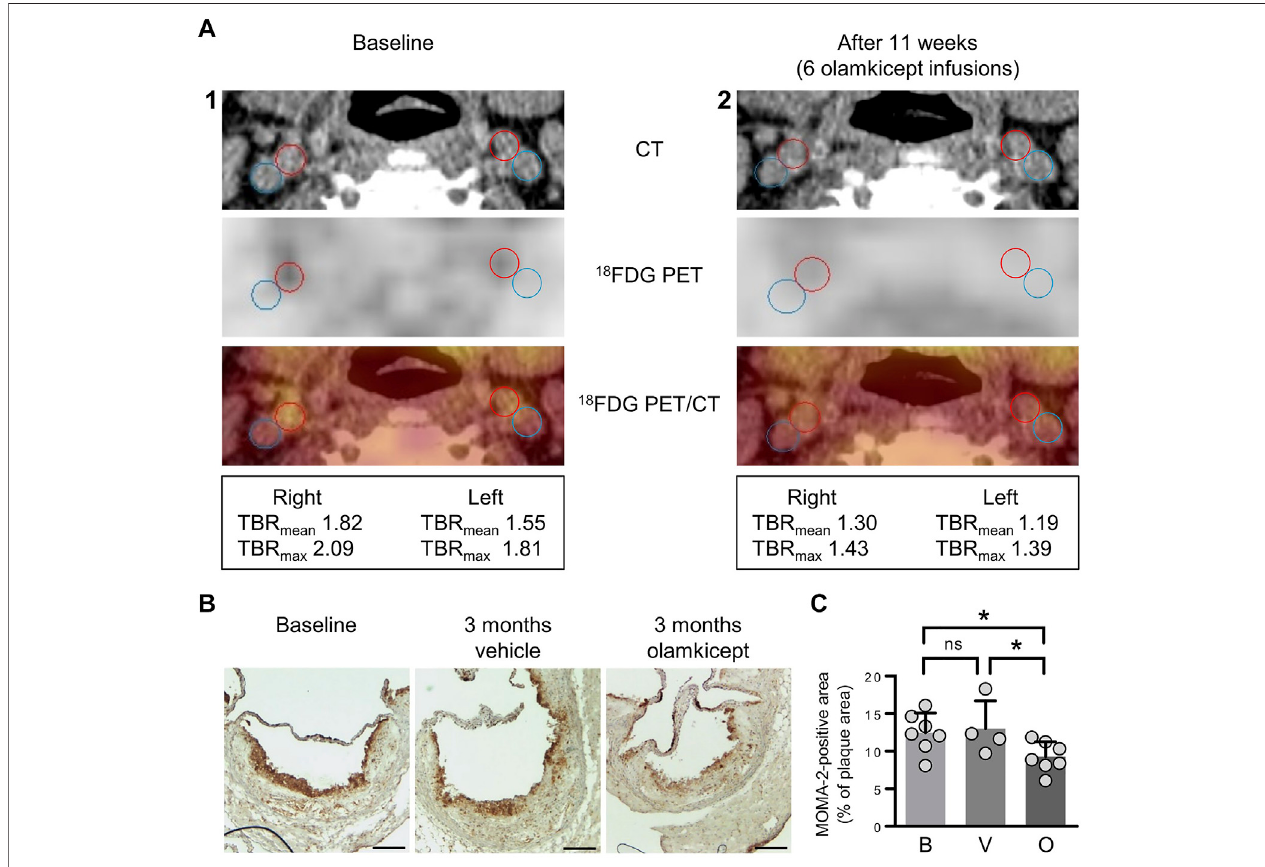
FIGURE2| Inhibition ofIL-6 trans-signallingreduces arterialwall in fl ammation and macrophage in fi ltration ofatherosclerotic plaques inend-stageatherosclerosis. (A) Arterial wall in fl ammation in the carotid arteries of the patient (1) at baseline and (2) 11 weeks after the beginning of olamkicept treatment (6 infusions of 600 mg i. v. biweekly; Table1 ).Intherepresentativeaxialcomputed tomography(CT), 18 fl uorodeoxyglucosepositronemission tomography( 18 FDG PET),andfusedimages( 18 FDG PET/CT), regions of interest are highlighted by red (artery) and blue circles (vein). Mean and maximum target-to-background ratio (TBR mean and TBR max ) are listed below. (B,C) New analyses of samples from a previous study in a murine model of experimental atherosclerosis (Schuett et al., 2012) (B) Representative MOMA-2- stained(macrophage-positive)lesionsinaorticrootsections(scalebars=250 µm)of Ldlr − / − mice( n =4to n =7pergroup)after12 weeksonahigh-fat,high-cholesterol diet followed by another 12 weeks on the same diet combined with vehicle or olamkicept treatment (0.5 mg/kg intraperitoneally, twice weekly); (C) MOMA-2 levels expressedaspercentage(mean,standarddeviation)oftheMOMA-positive(+)totalplaqueareaatbaseline(B)oraftervehicle(V)orolamkicepttreatment(O);*, p < 0.05; ns, not signi fi